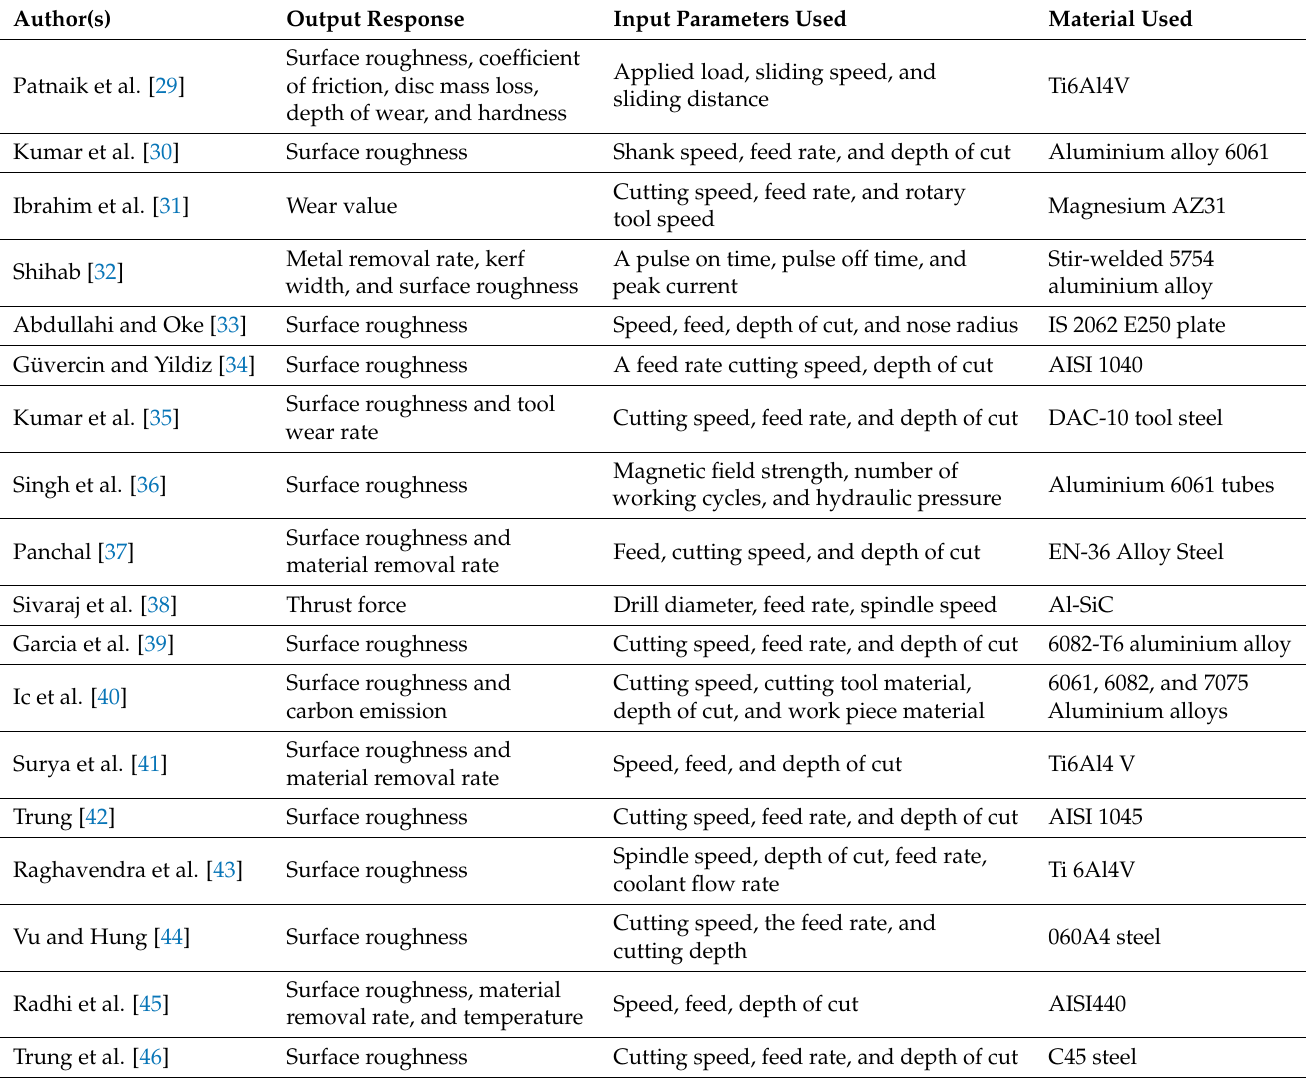
Table 1. The literature review